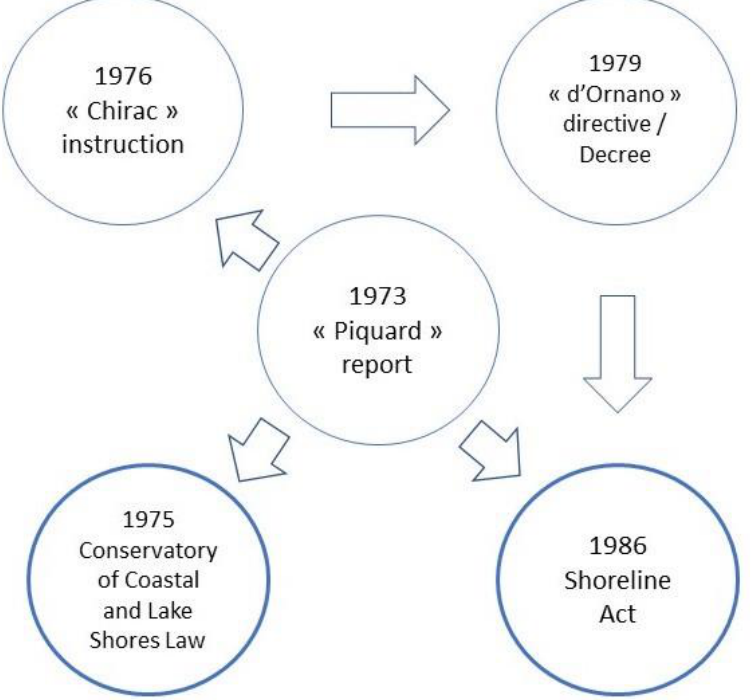
Figure 5. Diagram of the relation between the different texts that influenced the writing of the Shoreline Act. Made by Catherine Roche.